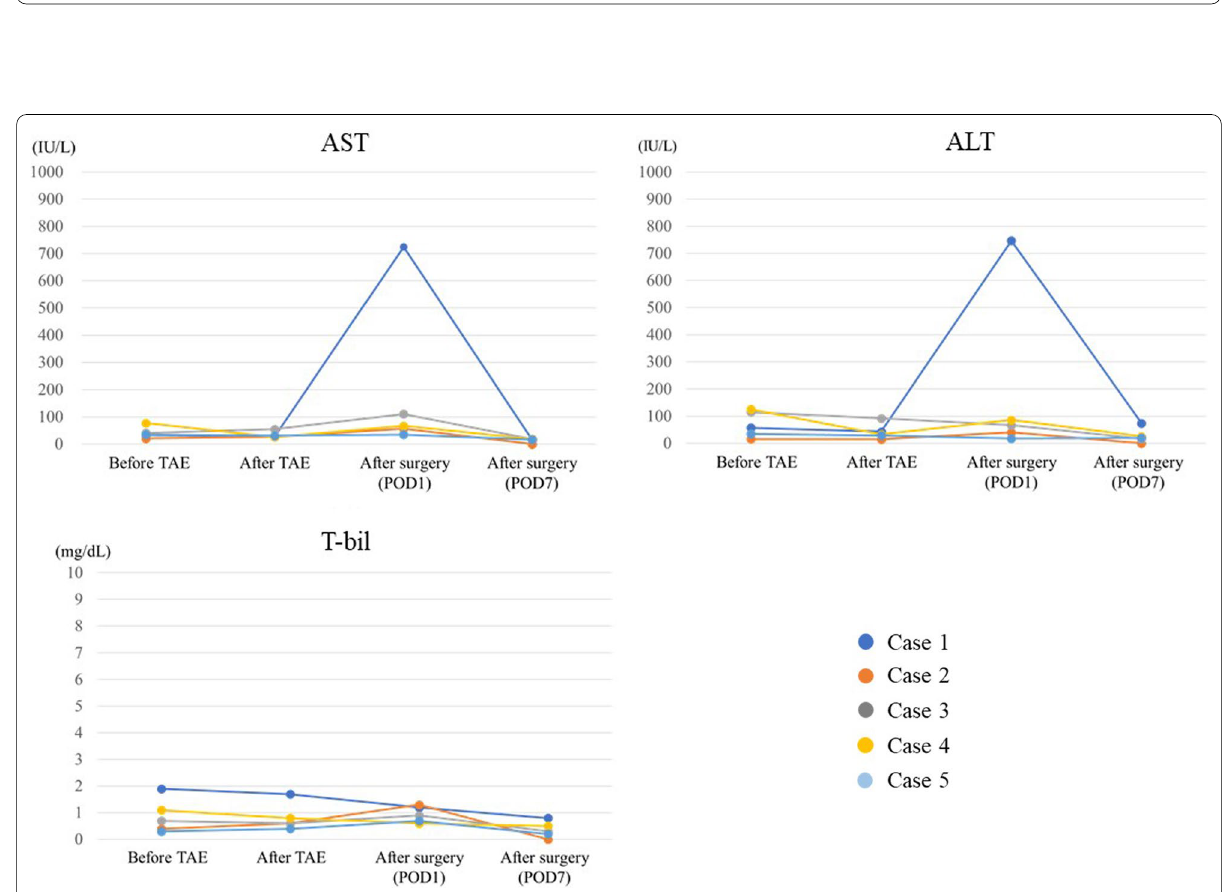
Fig. 2 Angiography after the embolization of rRHA in the four cases other than case 4. In all cases, the blood flow to the right lobe of the liver was commonly supplied by the communicating arcade from the LHA via the hilar plate (red circle). These vessels were enhanced (Cases 1, 2, and 3) or retained (Case 5) after embolization. rRHA replaced right hepatic artery; LHA left hepatic artery; Pre pre-embolization of rRHA; Post post-embolization of rRHA